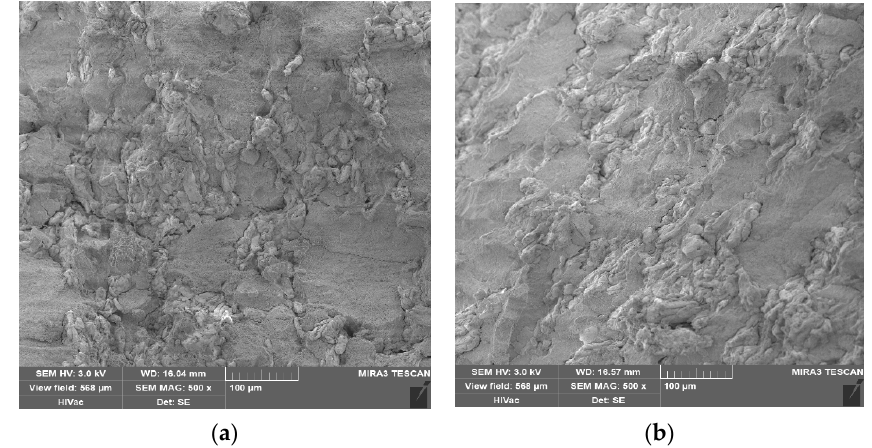
Figure 2. Images of Blank_E_HA_180 min ( a ) and Blank_E_MW_3 min ( b ).